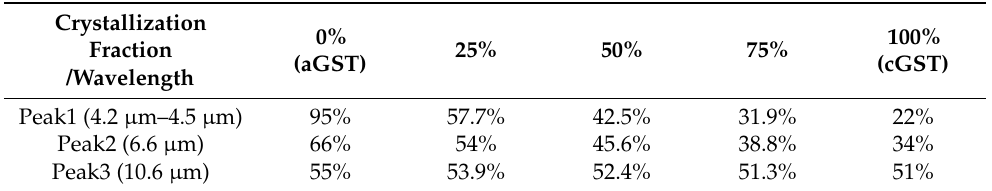
Table 1. Absorptivity variation of the main absorption peaks of the device at different crystalline fractions of